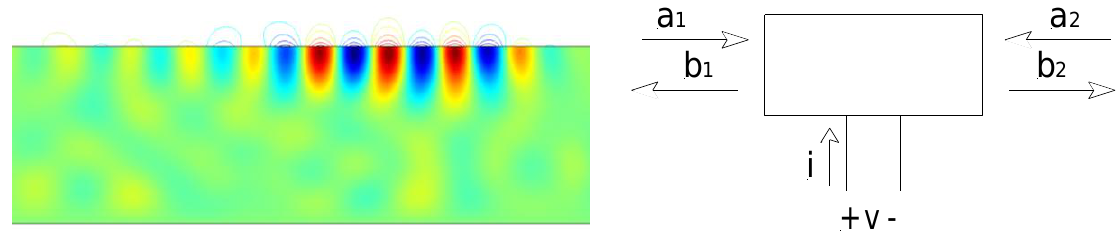
Figure 2. Surface waves: ( Left ) surface wave propagating along the surface (lithium niobate substrate; color = y displacement (red, positive, green negative), contour = electric field, computed at a center frequency of 450 MHz); and ( Right ) model of an interdigitated transducer showing incident and reflected